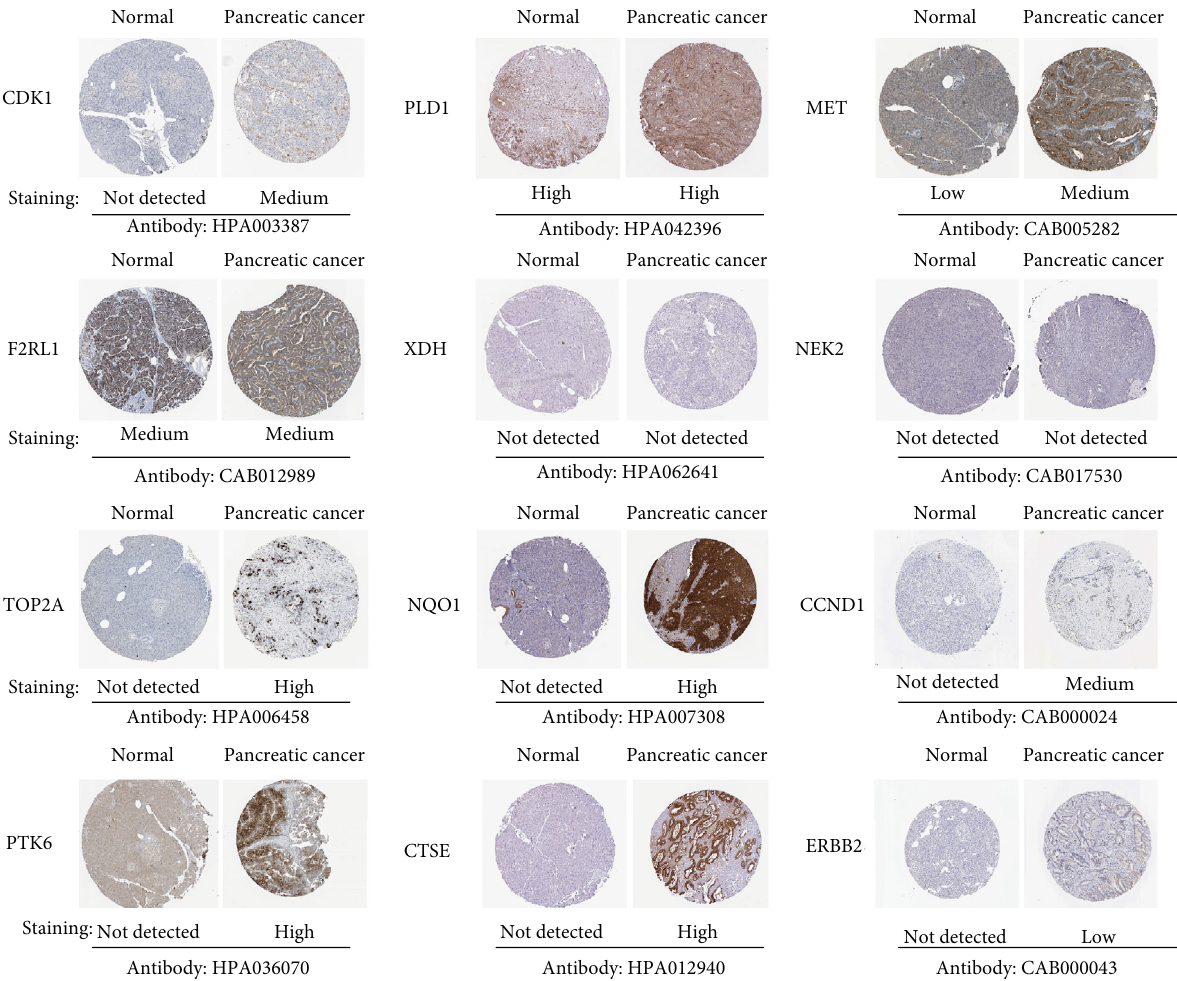
Figure 10: Representative immunohistochemistry images of 12 overlapped DEGs in PDAC tissues and normal pancreatic tissue based on Human Protein Atlas. CDK1, TOP2A, NQO1, CCND1, PTK6, CTSE, and ERBB2 proteins were not expressed in control pancreatic tissues; however, their low, medium, and high expressions were detected in PDAC tissues. Low protein expressions of MET was observed in normal pancreatic tissues, whereas there was a medium expression of MET in pancreatic cancer tissues. Signi fi cantly, the high, medium expression of PLD1 and F2RL1, respectively, were found in both tissues. Also, we found that XDH and NEK2 were not expressed in both cancer and normal